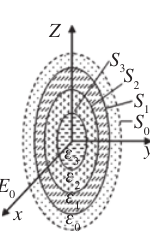
Figure 2: Scheme of the Bruggeman’s analytical model for a mixture with aligned three-layer